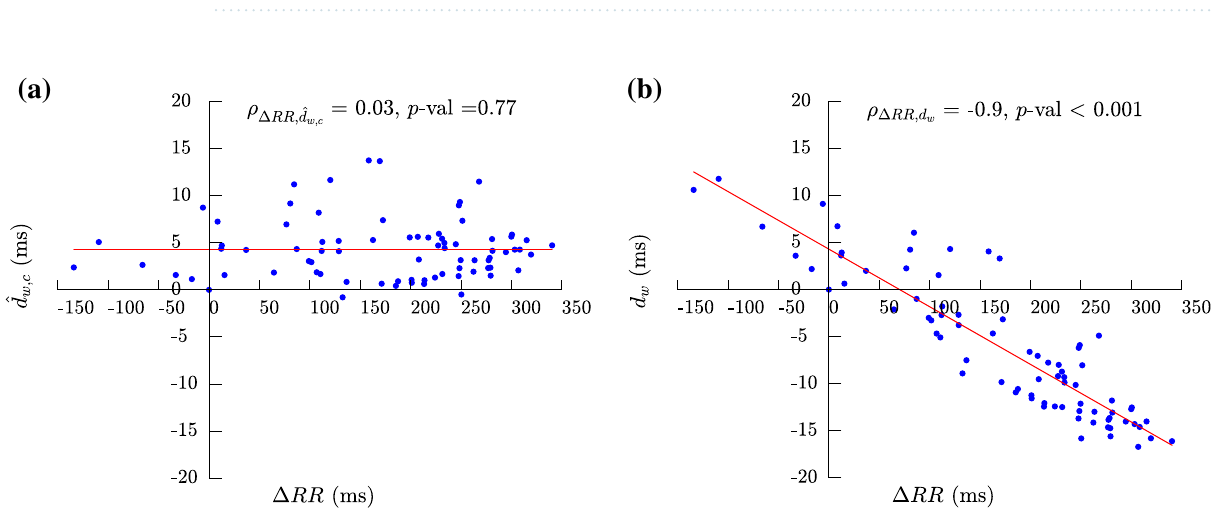
Figure 3. Scatterplot showing the values of both d w panel ( a ) and patient in PCA approach. Spearman’s correlation coefficients ( ρ ) and p -values for both d w and top of each panel, while the least-square fitting regression lines are plotted in